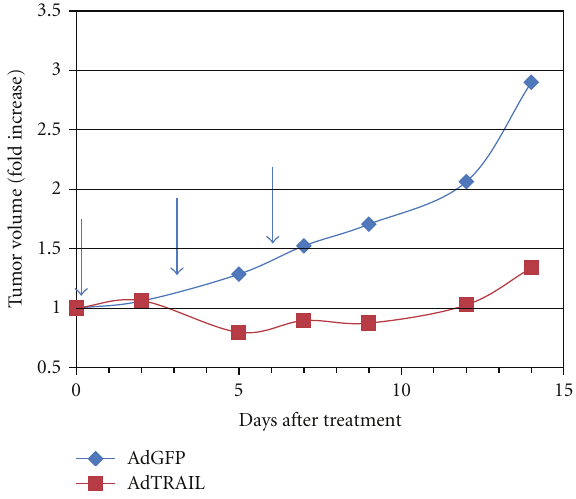
Figure 1: E ffi cacy of AdTRAIL in subcutaneous C4-2b xenografts. Male mice were subcutaneously injected with 2 million C4-2b cells. After tumor establishment, mice received three intratumoral injections of 1 × 10 9 IU of AdGFP or AdTRAIL every 3 days (arrows). Data shown are from 6 tumors/group ( P = 0 . 015).